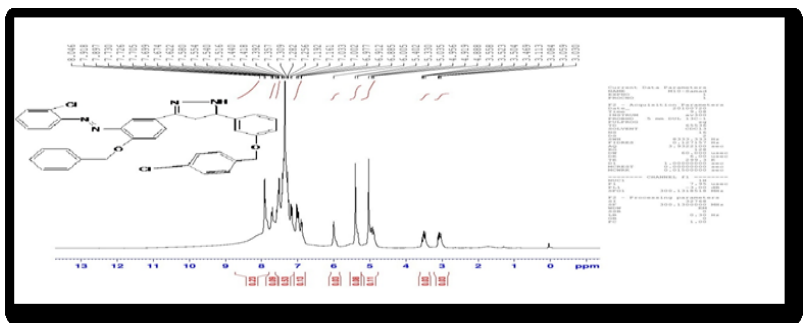
Figure 2: 1 H-NMR spectrum of compound